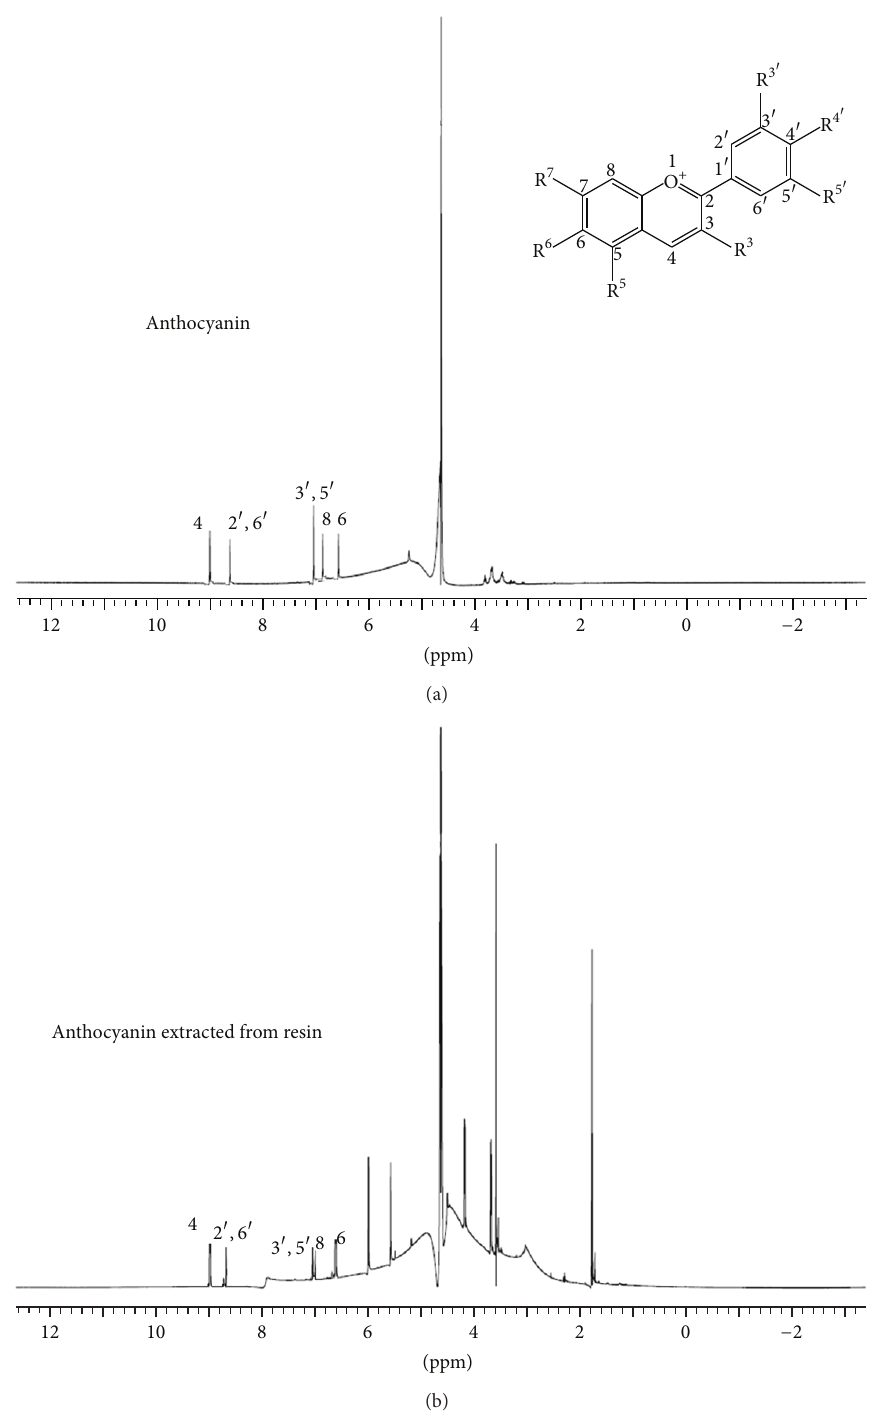
Figure 2: 1 H NMR spectra of (a) anthocyanin compound; (b) anthocyanin released by dental